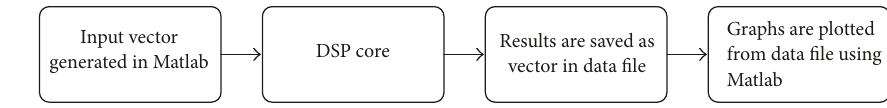
Figure 13: Process of configuring a DSP